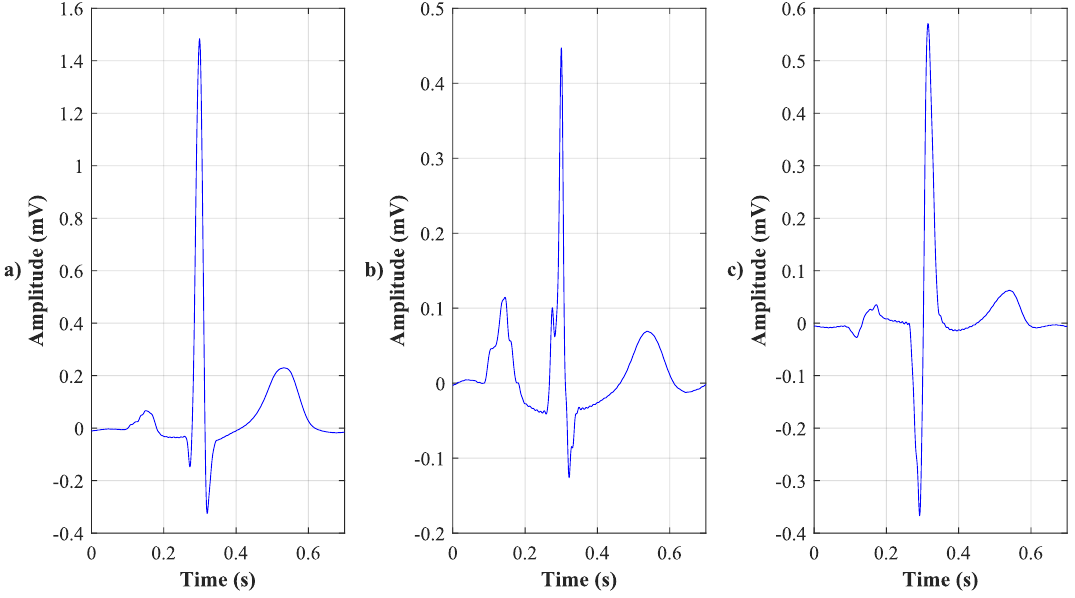
Figure 1. 1-D image of three scalar vectorcardiographic (VCG) recordings. ( a ) X lead, ( b ) Y lead, and ( c ) Z